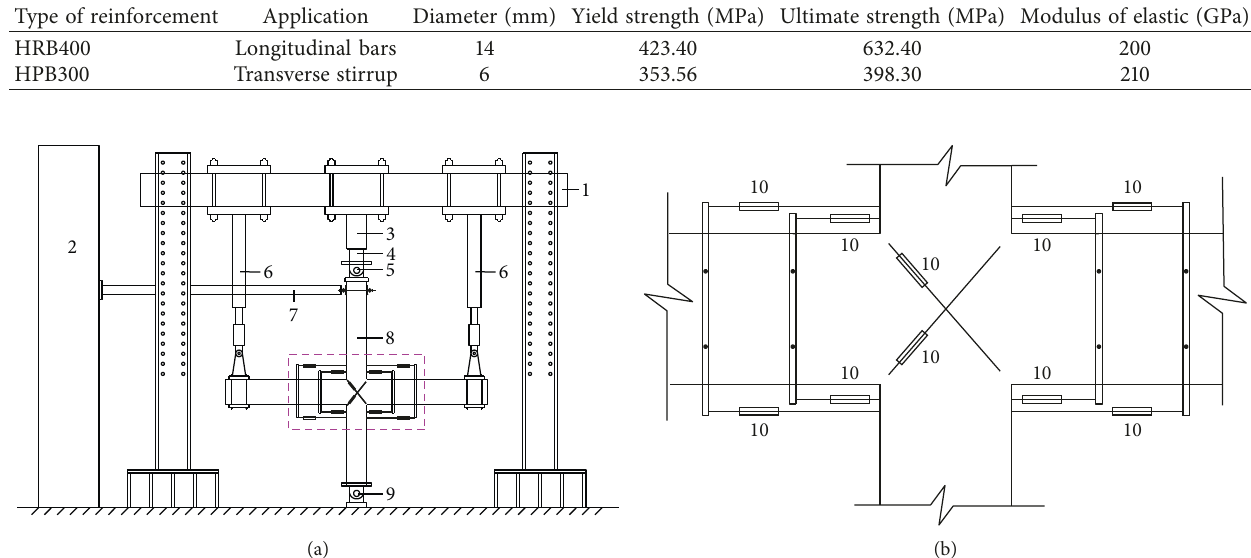
Table 4: Mechanical properties of reinforcing bars.